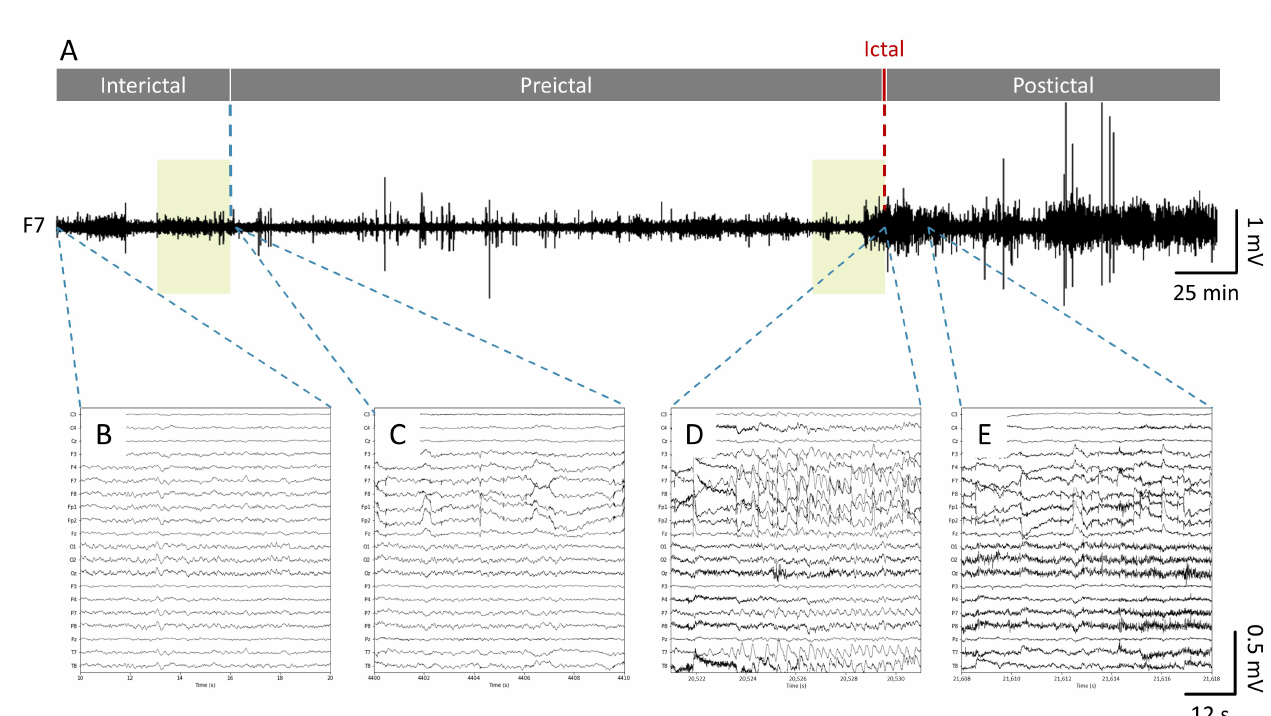
Figure 2. Standard segmentation for the EEG recording of an epileptic patient. ( A ) The trace depicts 480 min of recording from the F7 channel during a seizure divided into four main stages: interictal, preictal, ictal, and postictal. The green areas represent the 30 min from the preictal and interictal states used for the binary prediction task. Panels ( B – E ) illustrate magnifications of 20 s of recordings from 20 channels at the beginning of the interictal, preictal, ictal, and postictal states,